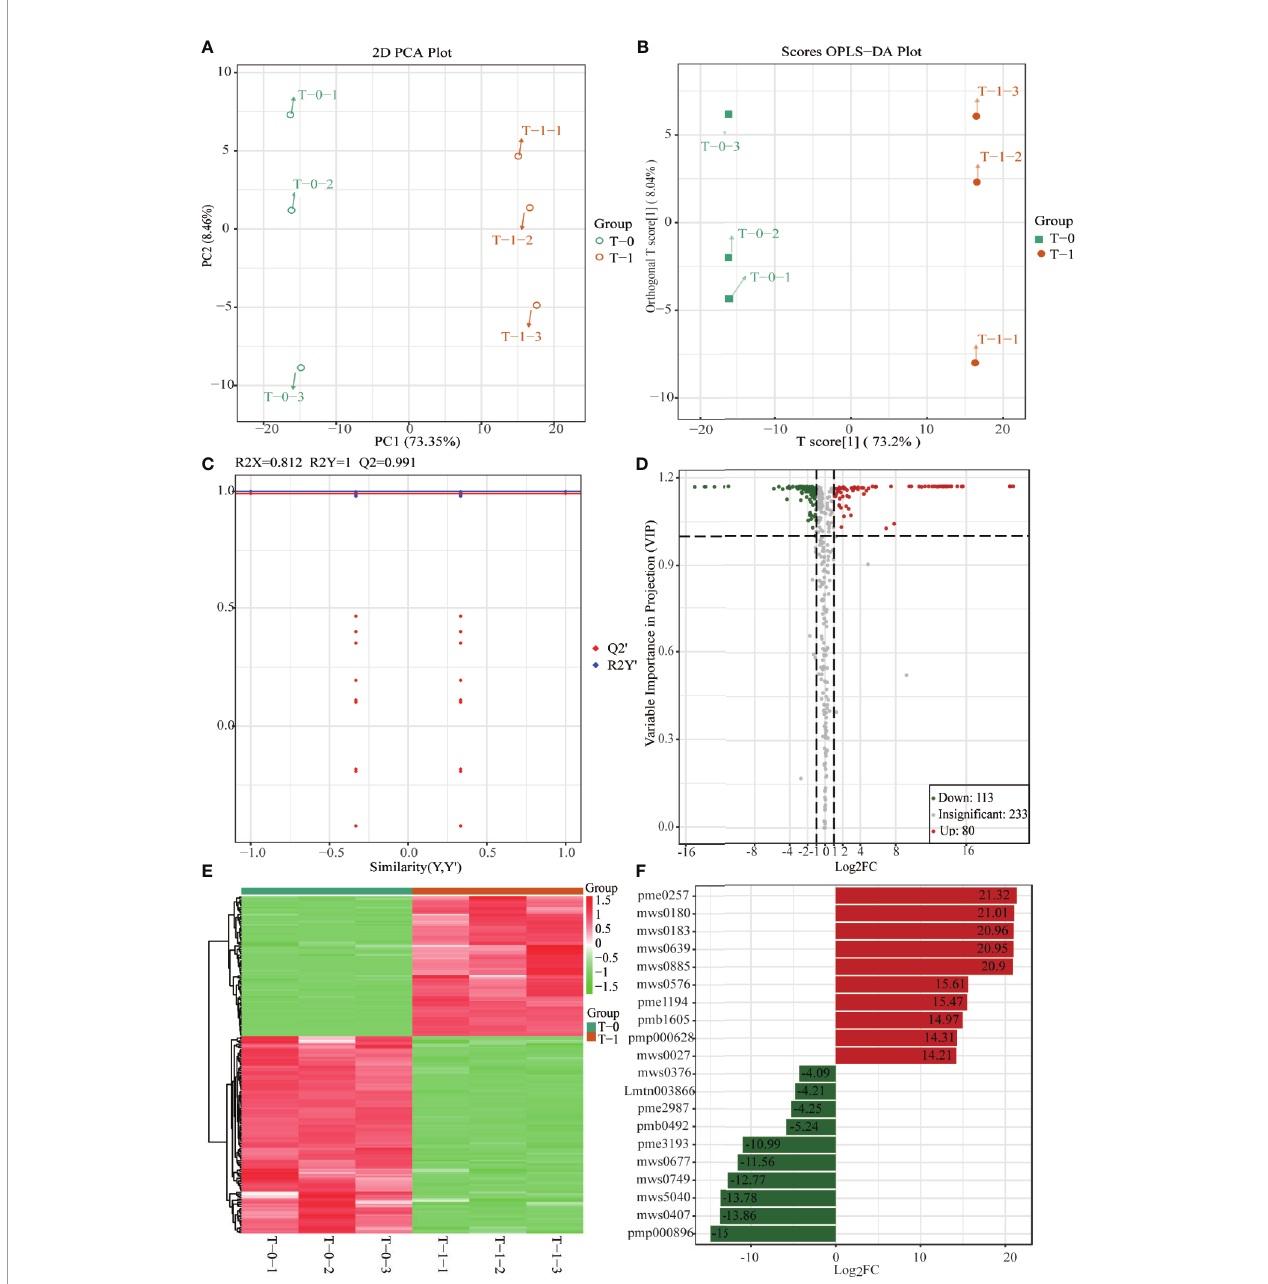
FIGURE 7 | Multivariate statistical analysis of methanol extracts of non-fumigated TR (0 h) and sulfur-fumigated TR (1 h) samples. (A) PCA plot; (B) OPLS-DA plot; (C) validation Plot for OPLS-DA model; (D) volcano plot; (E) heatmap; (F) Multiple fold change of metabolites after log2